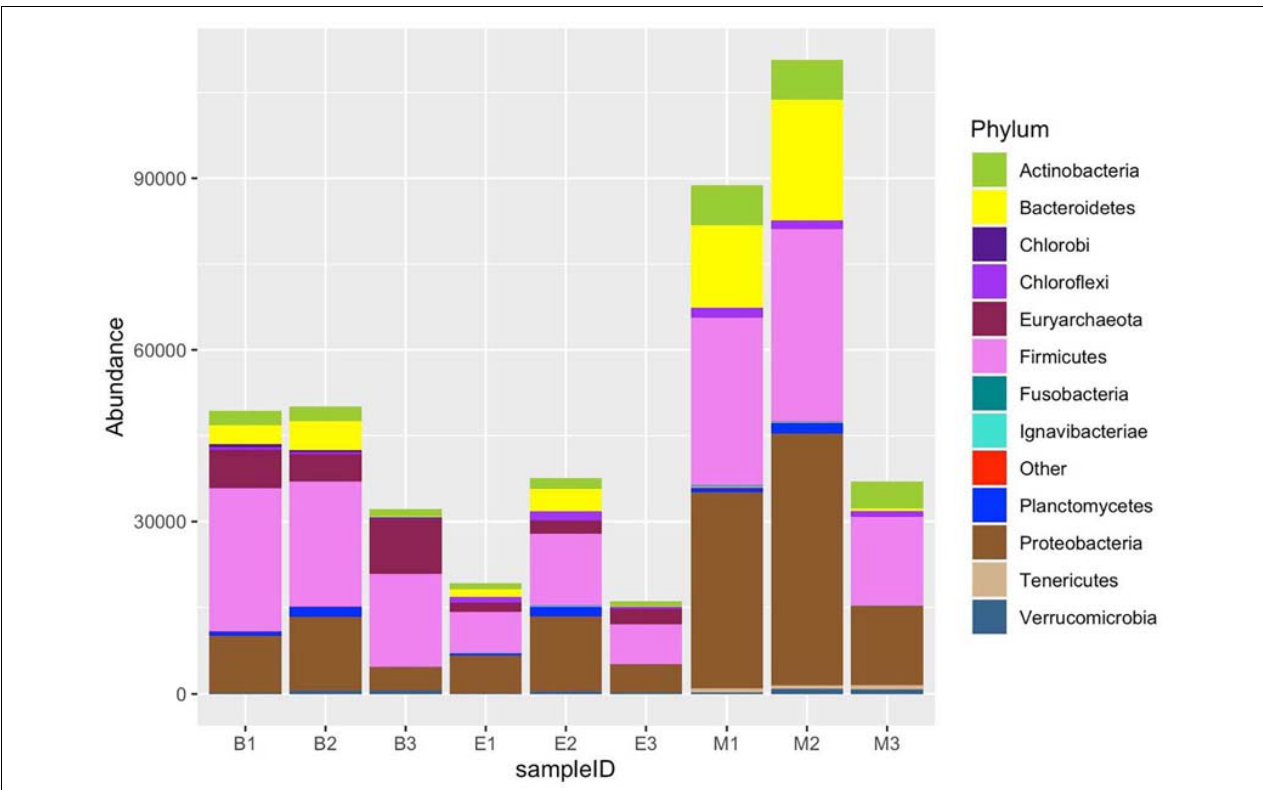
FIGURE 10 | Twelve most abundant phyla, detected by three universal prokaryote primers in each wetland. The remaining taxa with lower abundance are classified into “Other.” The abbreviations and numerics used are as follows: B, Bhomra; E, EKW; M, Malencho; 1, 341b4_F/806_R; 2, N341b4_F/806_R; 3, Pro341F/Pro805R; EKW, East Kolkata